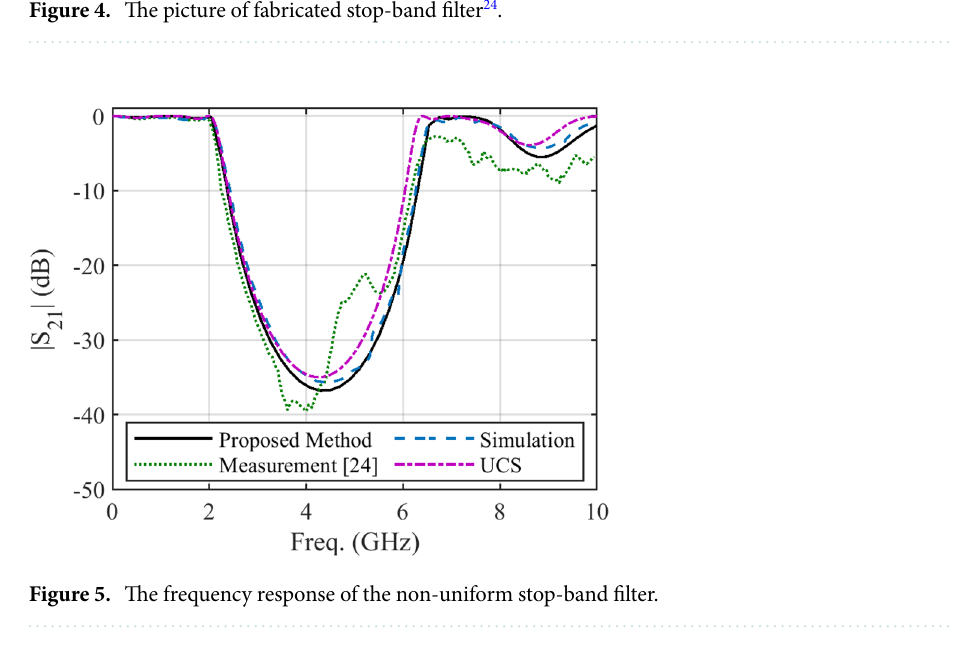
Figure 4. The picture of fabricated stop-band filter 24 .